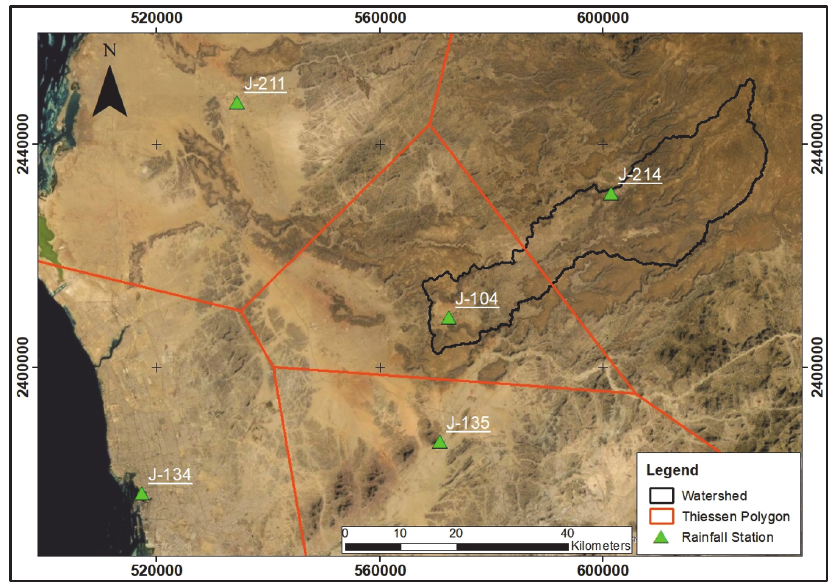
Figure 3. Rainfall stations in Al ‐ Lusub watershed overlayed with Thiessen Polygon.